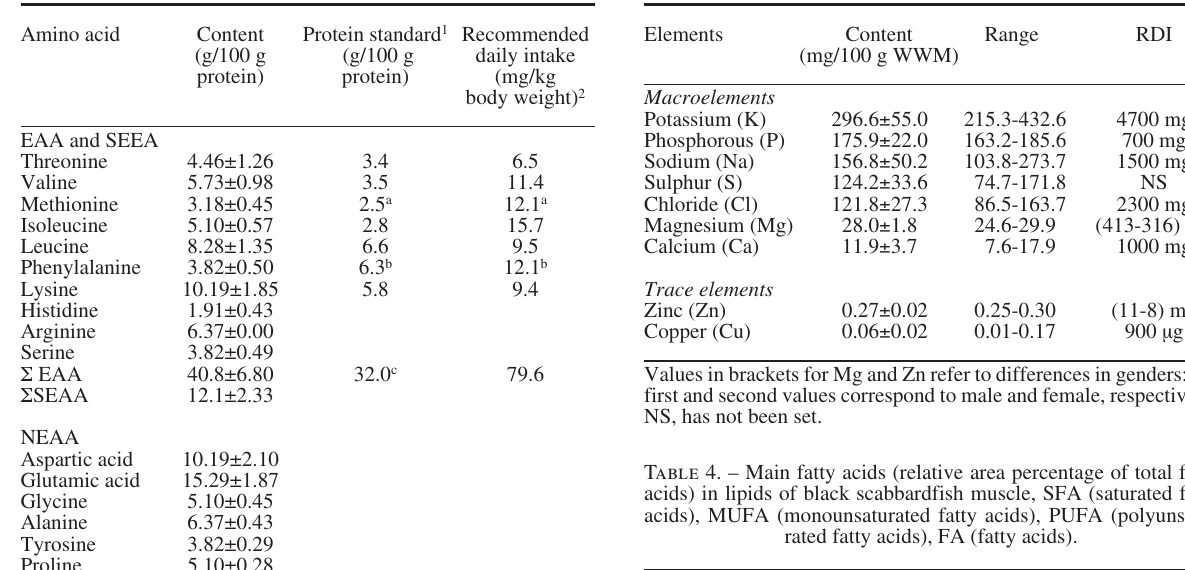
Table 2. – amino acid composition (g/100 g protein; mean ± stand- ard deviation) of black scabbardfish edible part, protein standard and human recommended daily intake.